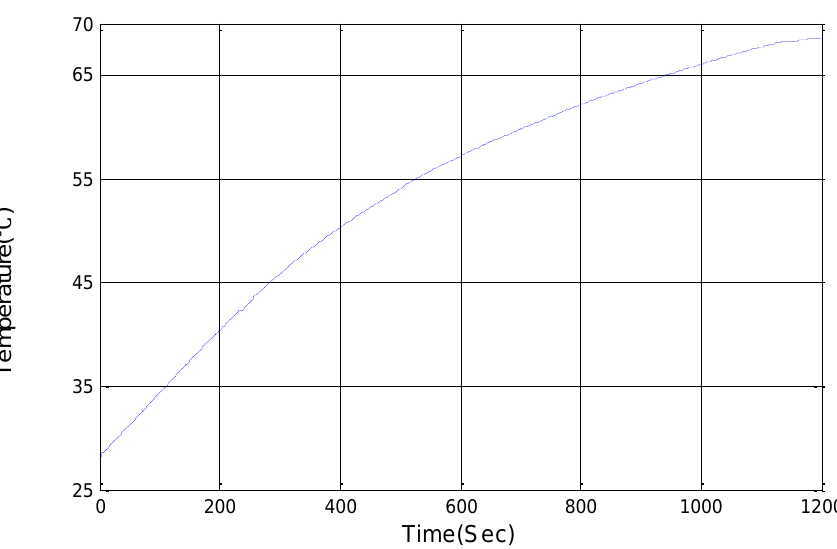
Figure 10. The temperature change.